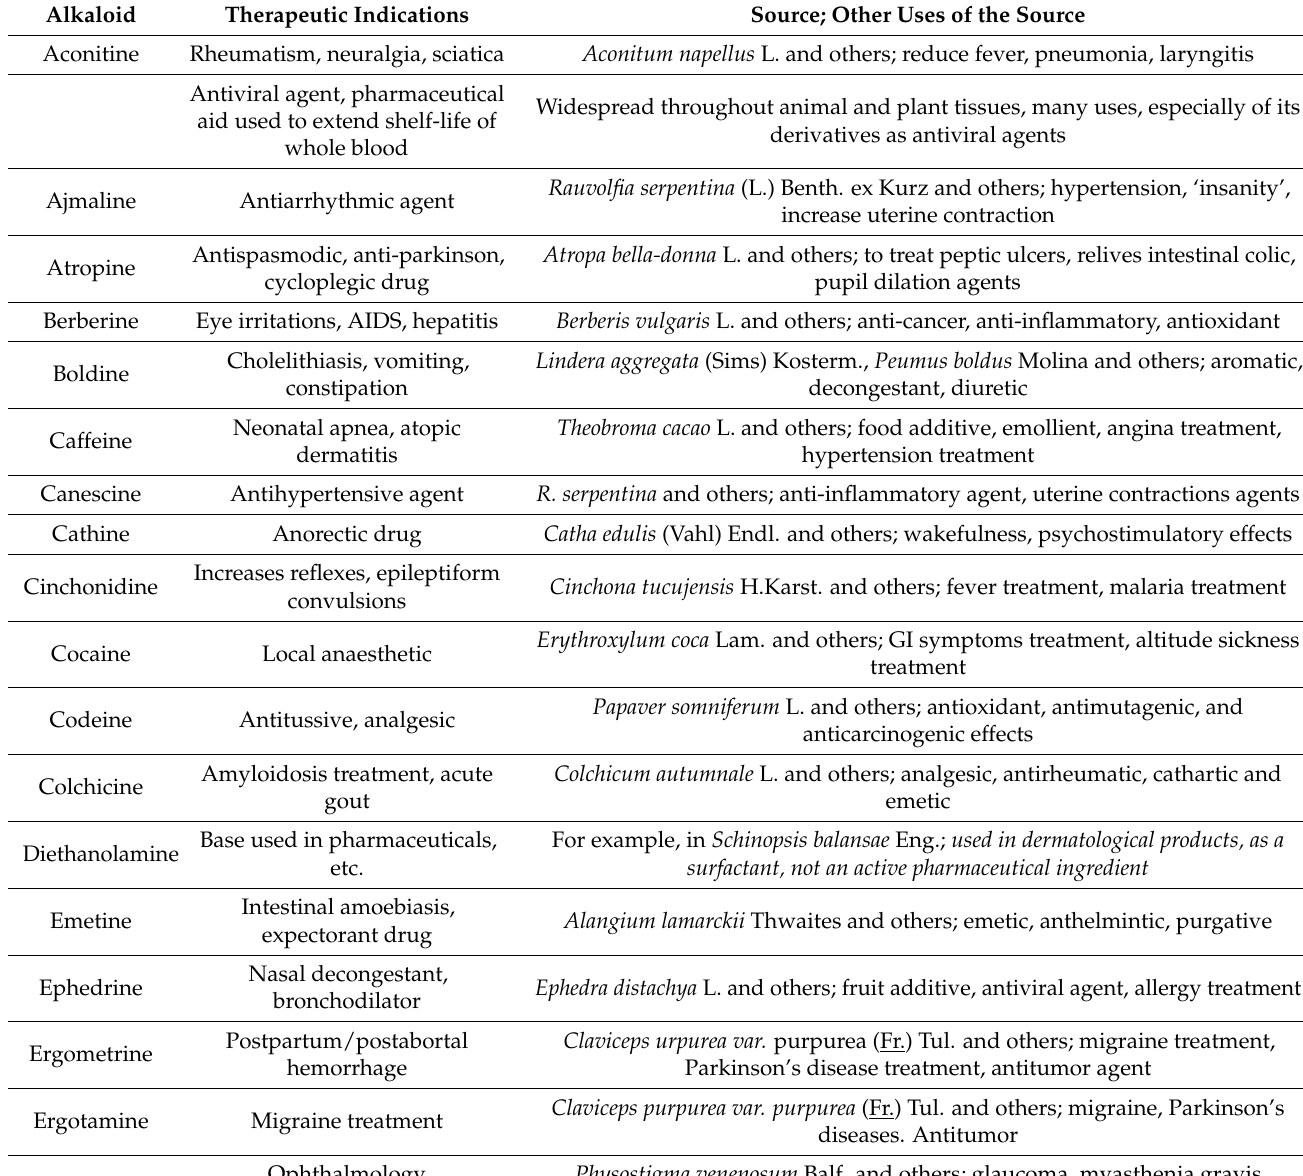
Table 2. Record of alkaloids used in marketed medicines, drugs, and clinical environments. The table was updated table based on Heinrich and Amirkia data from 2014 [18]. Table provides an overview of licensed alkaloids on the market as of 2020. Other sources are determined from DNP and associated uses are queried on